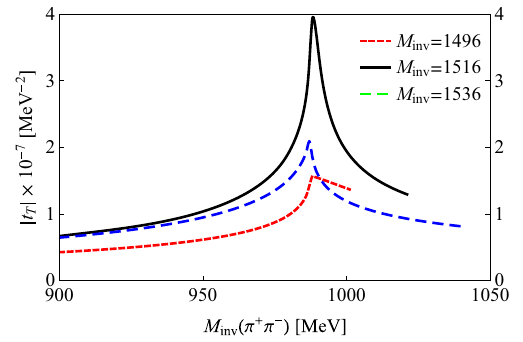
We also show 1 Γ